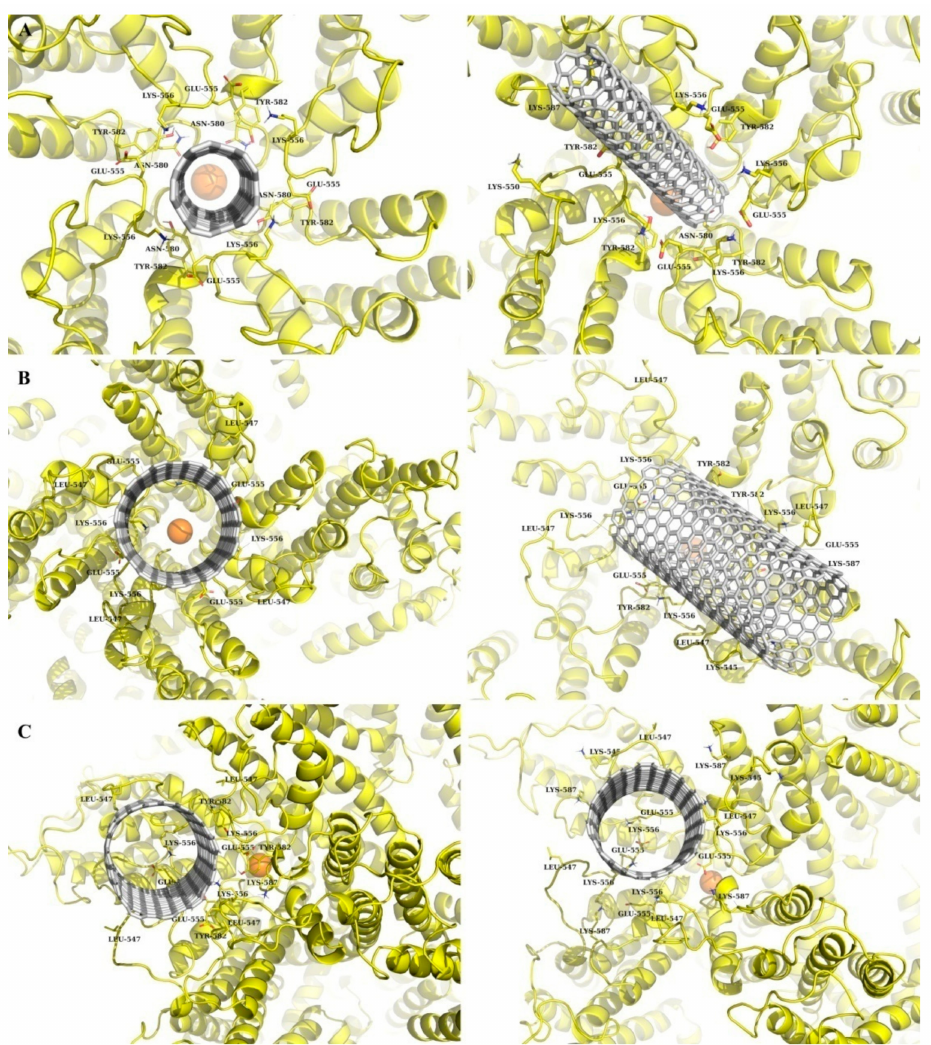
Figure 2. Results of molecular docking (left) and MD simulation (right) for SWCNTs: ( A ) SWCNT_1 model; ( B ) SWCNT_2 model, and ( C ) SWCNT_3 model. The TRPC4 channel is shown in yellow and SWCNT in grey.